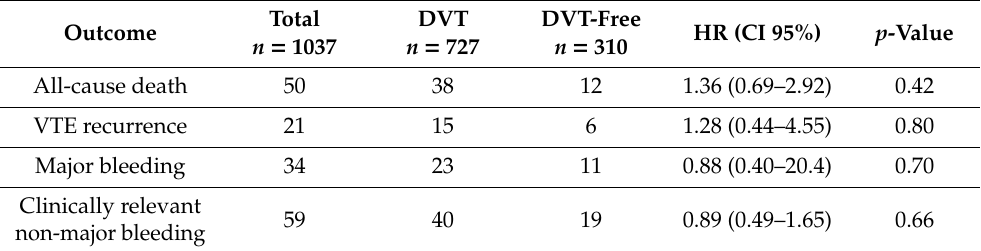
Table 3. Three-month adverse outcomes according to the presence of coexisting deep vein thrombosis.